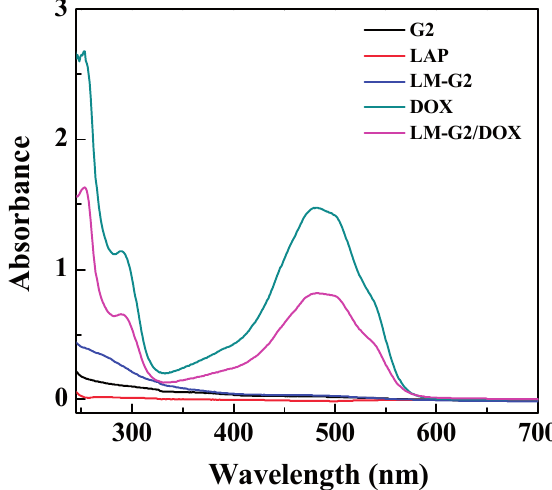
Figure 4. UV-Vis spectra of G2, laponite ® (LAP), LM-G2, free DOX, and